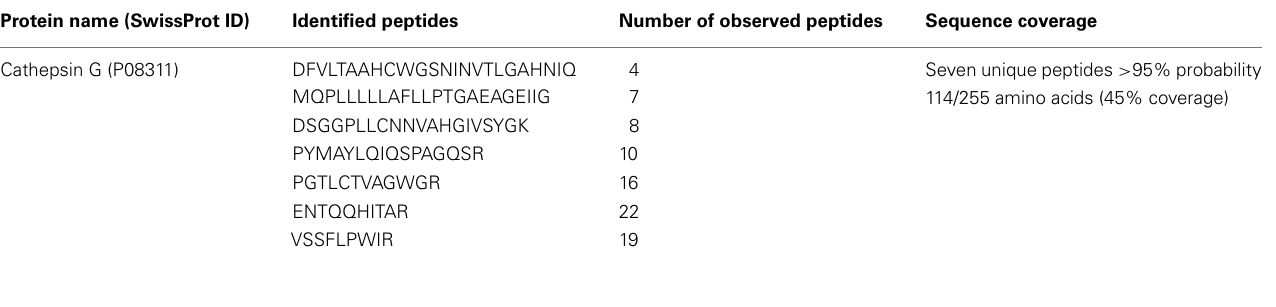
Table 2 | Mass spectrometry analysis of host protein interacting with M. tuberculosis